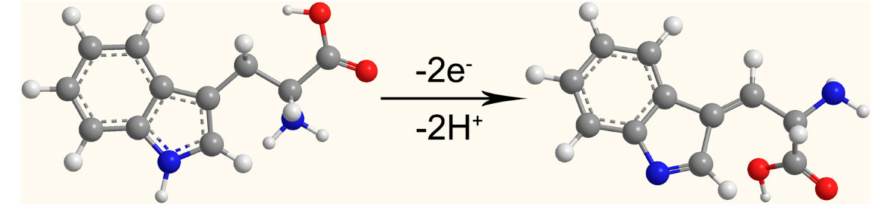
Figure 5. The oxidation pathway of